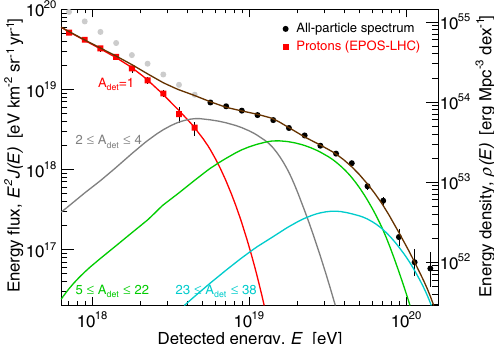
Figure 3. Energy flux at Earth as a function of energy, as modeled by the best-fit parameters for the benchmark scenario. The all-particle spectrum and proton component are shown as black circles and red squares, respectively [11]. Lighter points are not included in the fit. The best-fit components obtained for five detected mass groups are displayed with solid colored lines, as labeled in the Figure. The energy flux of the heaviest mass group, with detected mass number in 39–56, is below the range of interest.